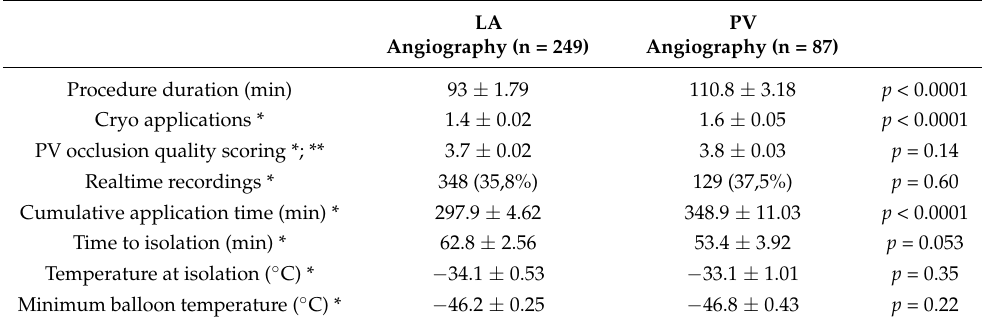
Table 2. Procedural parameters.